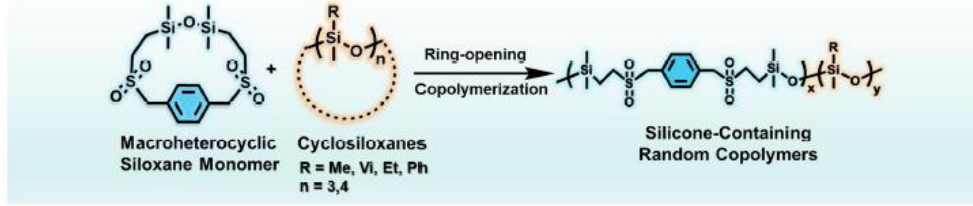
Figure 37. Ring-opening copolymerization of Macroheterocyclosiloxane and Cyclosiloxane (adapted with permission from Ref. [156]. 2021, Guo, M.)